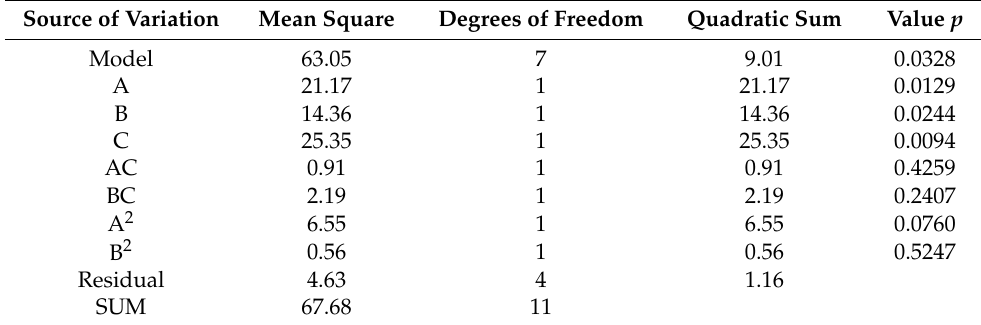
Table 6. Variance of 3-day curing cementitious material compressive strength model. Source of